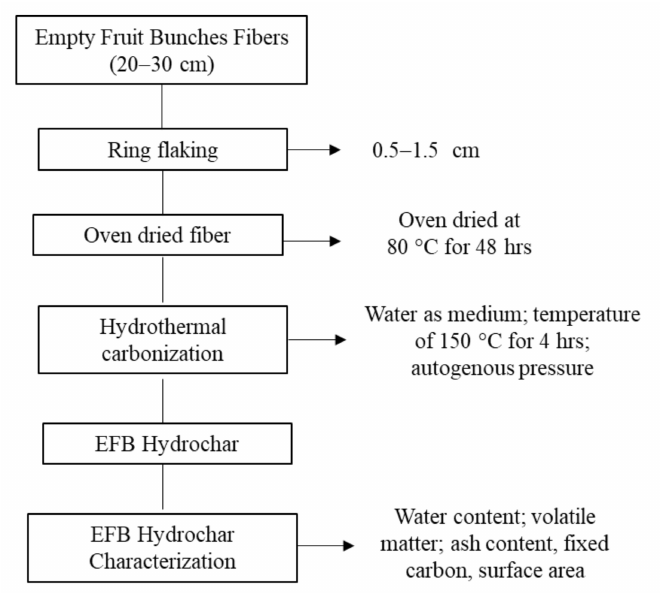
Figure 1. Flowchart of manufacture and characterization of EFB